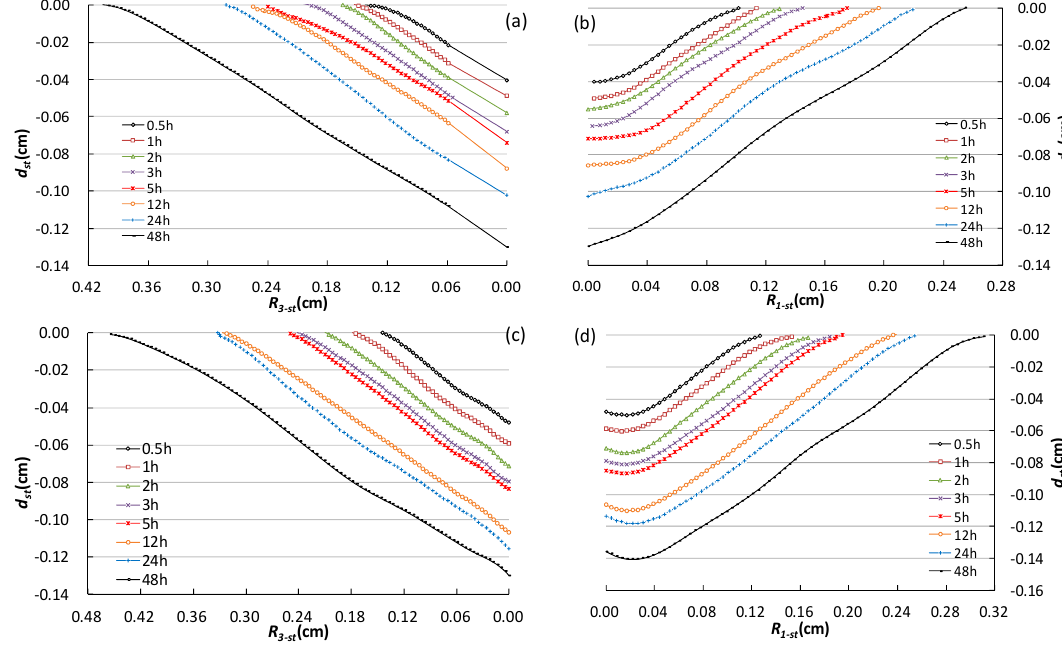
st and d st A st .